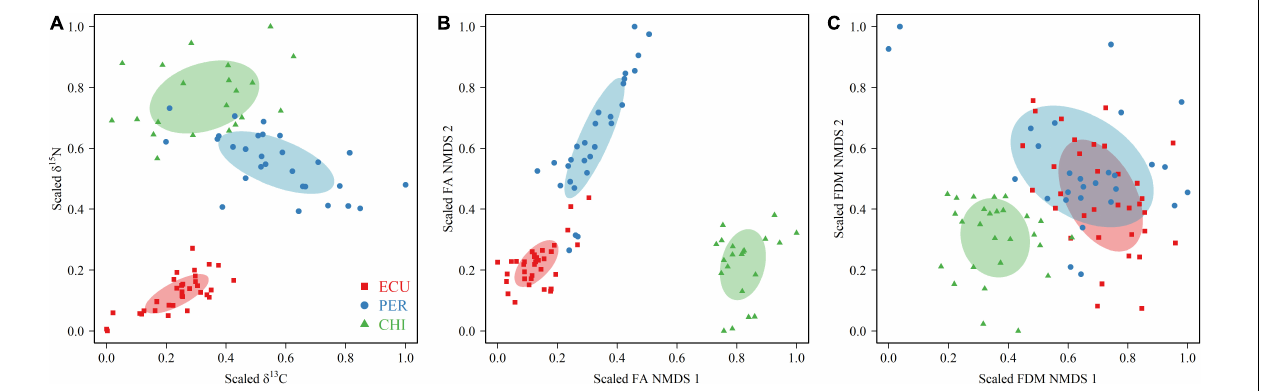
FIGURE 3 | Estimation of trophic niches using scaled δ 13 C and δ 15 N values (A) and coordinates in the two dimensions of the non-metric multidimensional scaling (NMDS) of fatty acid (FA) (B) profiles and feeding apparatuses morphology (FDM) (C) data of squid of Dosidicus gigas sampled from the waters off the Ecuadorian, Peruvian and Chilean Exclusive Economic Zone (ECU, PER, and CHI, respectively). The area of the ellipses (calculated with SEAc) represents the (A) isotopic, (B) FA, and (C) FDM trophic niche of each geographic stock.